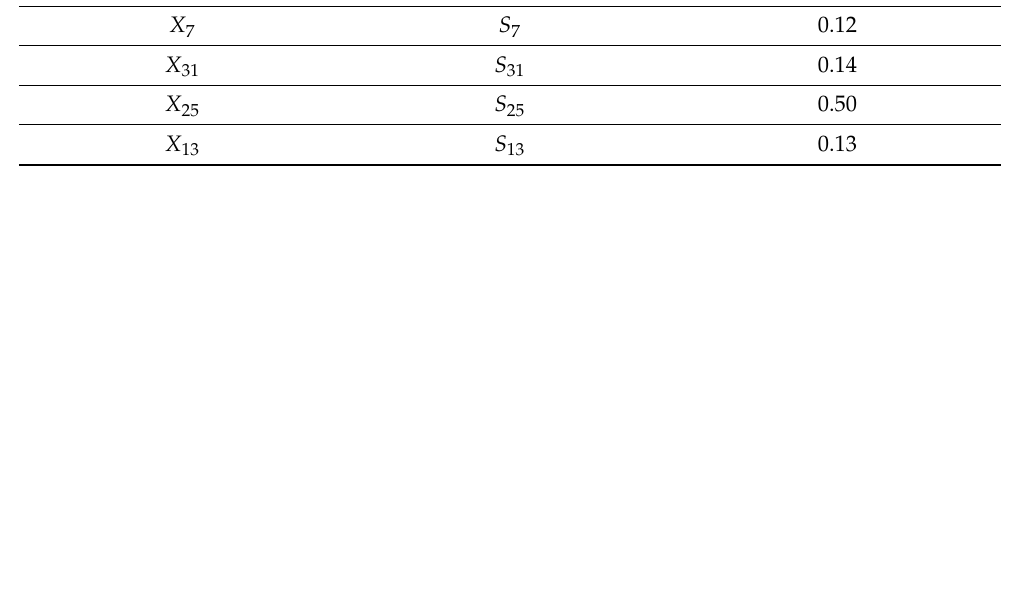
Table 7. Weights of the switches for the controller placement in cluster 4 (dark yellow). S.